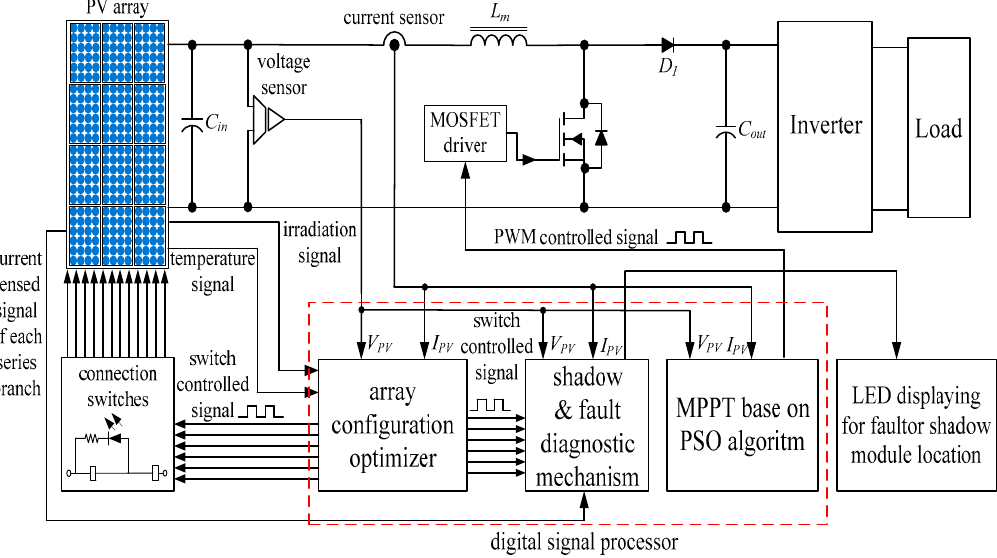
Figure 2. The framework of the presented online fault detection system.